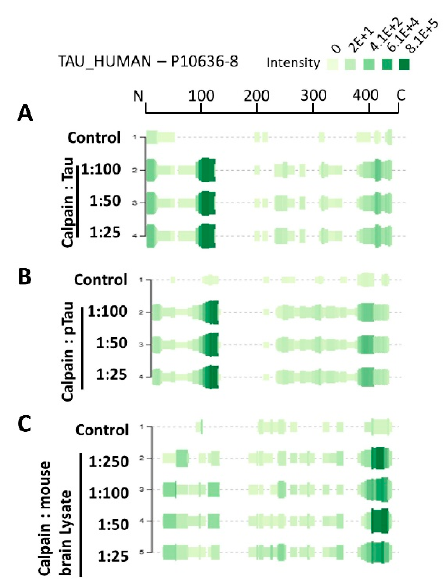
Figure 4. Tau proteolytic peptides heatmap profile from samples digested by calpain. ( A – C ) shows mass spectrometric intensities peptide profile of calpain-mediated tau, p-tau, and mouse brain, respectively (accession#: P10636-8). At each amino acid residue along the protein, the height of the green bars is proportional to the count of peptides overlapping this position. The intensity of the color (green) is proportional to the sum of the peptide intensities overlapping this position. The left side of the plots shows the dilution of calpain used for each condition.